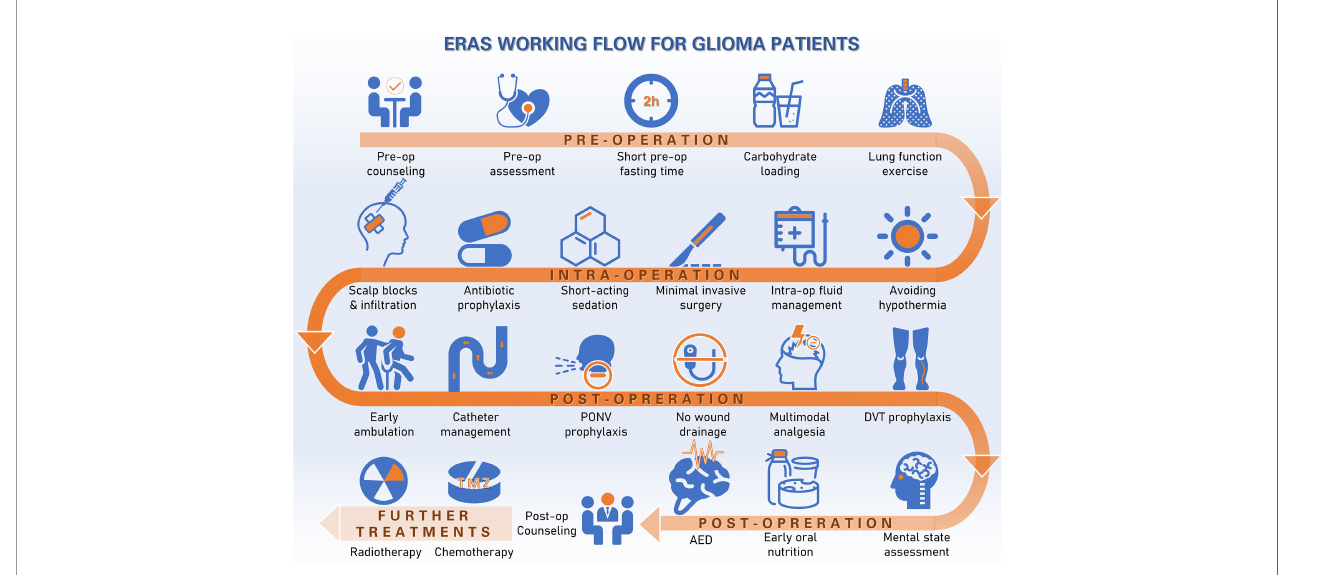
FIGURE 1 | Working fl ow of ERAS protocol for